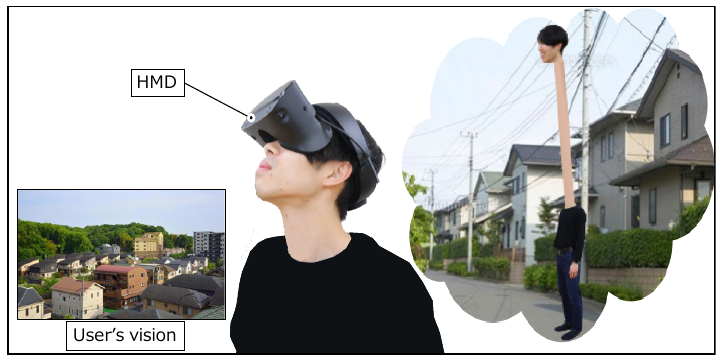
Figure 1. Extensible neck